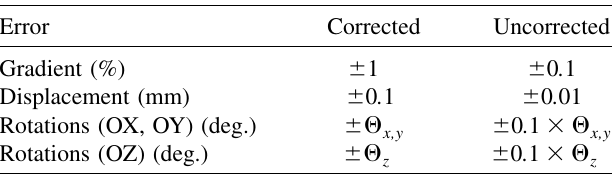
TABLE X. The amplitudes of errors for the magnetic quadru-